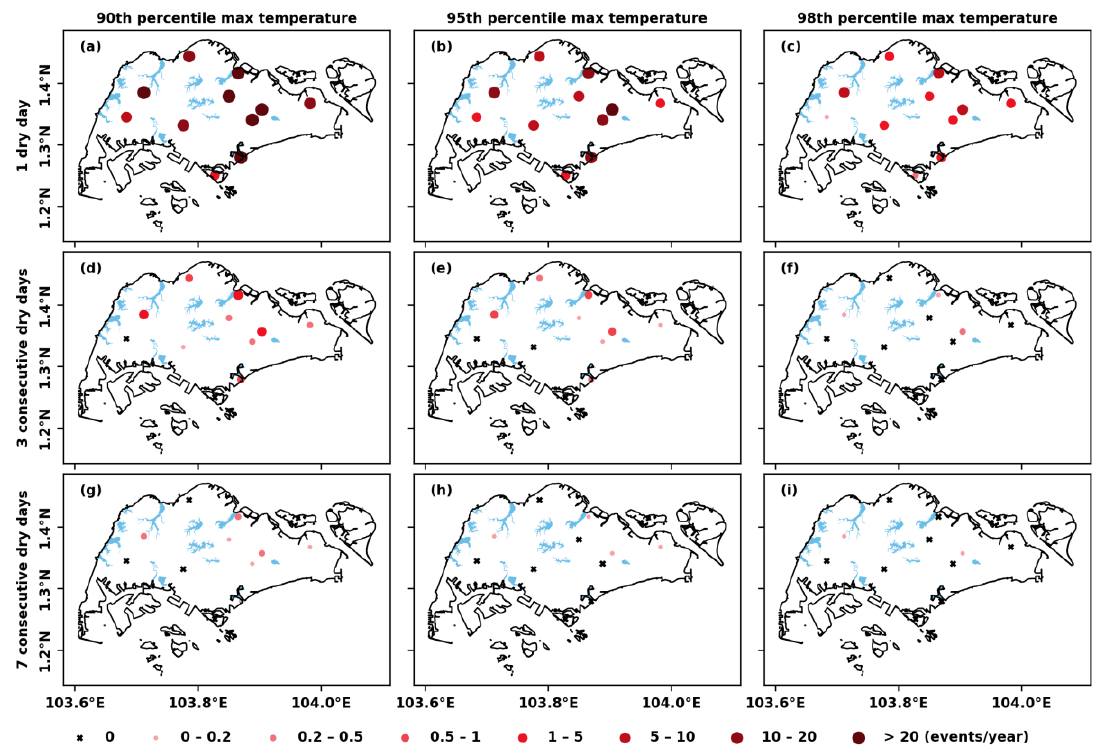
Figure 6. Frequency (events/year) of concurrent dry and hot extremes across Singapore. Rows represent different number of consecutive dry days (1, 3, and 7 days). Columns represent daily maximum air temperature thresholds (90th, 95th, and 98th percentiles).